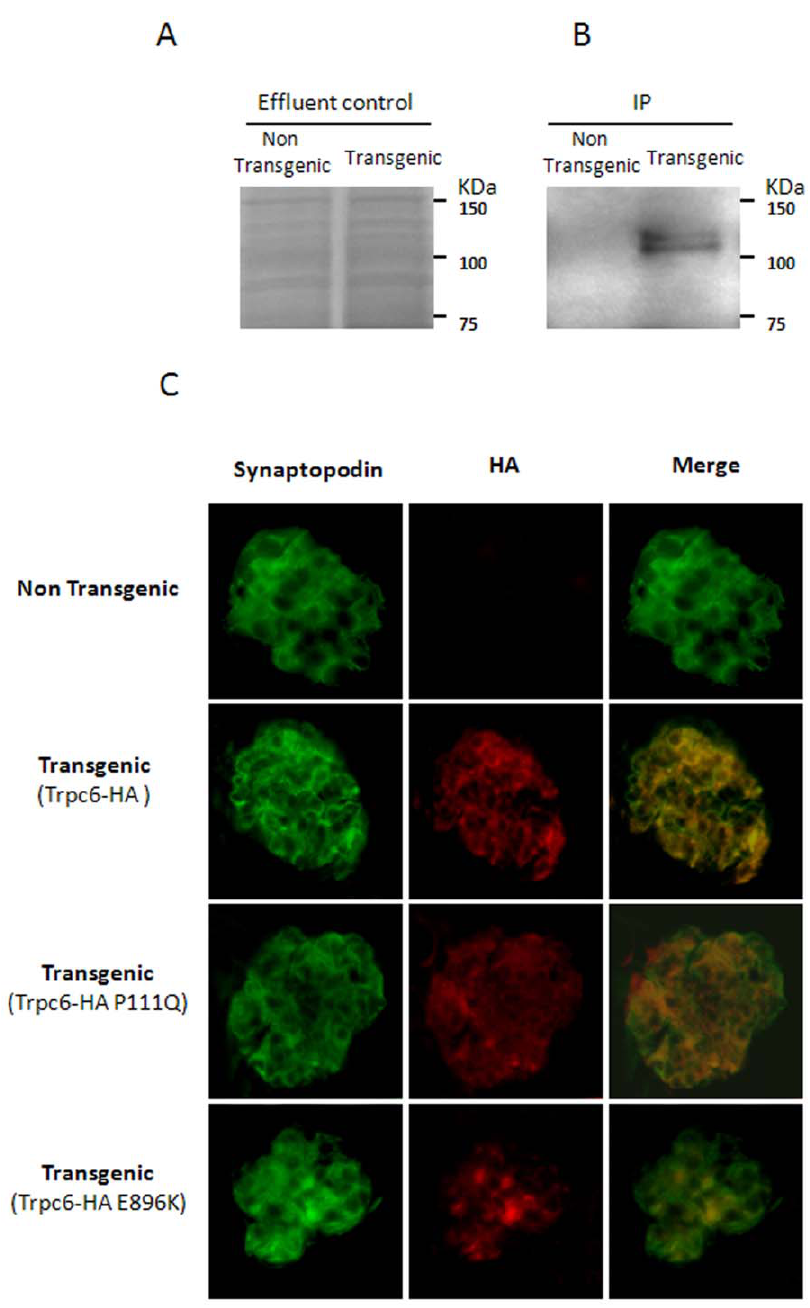
Figure 3. Protein expression in transgenic mice. (A) The in vivo Trpc6-HA expression was confirmed by Immunoprecipitation (IP). The IP was performed from isolated mouse glomeruli (n=8 kidney from each genotype) as described in material and methods. The glomeruli fraction was loaded into an HA affinity column, and a 30 m l aliquot of the sample which did not bind into the column was loaded in a gel and stained with Coomassie brilliant blue as a loading control (effluent control) for transgenic and non transgenic samples. (B) 30 m l of each IP sample was run in a SDS PAGE and a Western blot analysis against HA epitope was performed. (C) Double immunofluorescence of kidney cryosections to detect synaptopodin (green) and HA (red) for every transgenic line utilized in this study (400x).